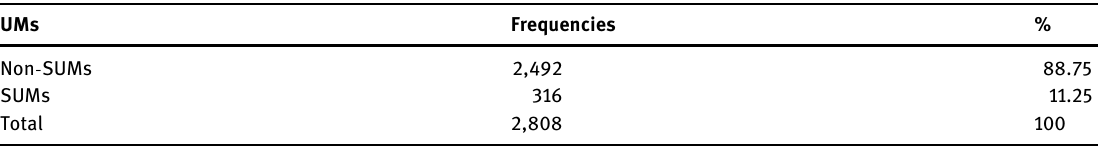
Table 2: Frequencies and percentages of SUMs and non - SUMs in the whole corpus UMs Frequencies % Non - SUMs 2,492 SUMs 316